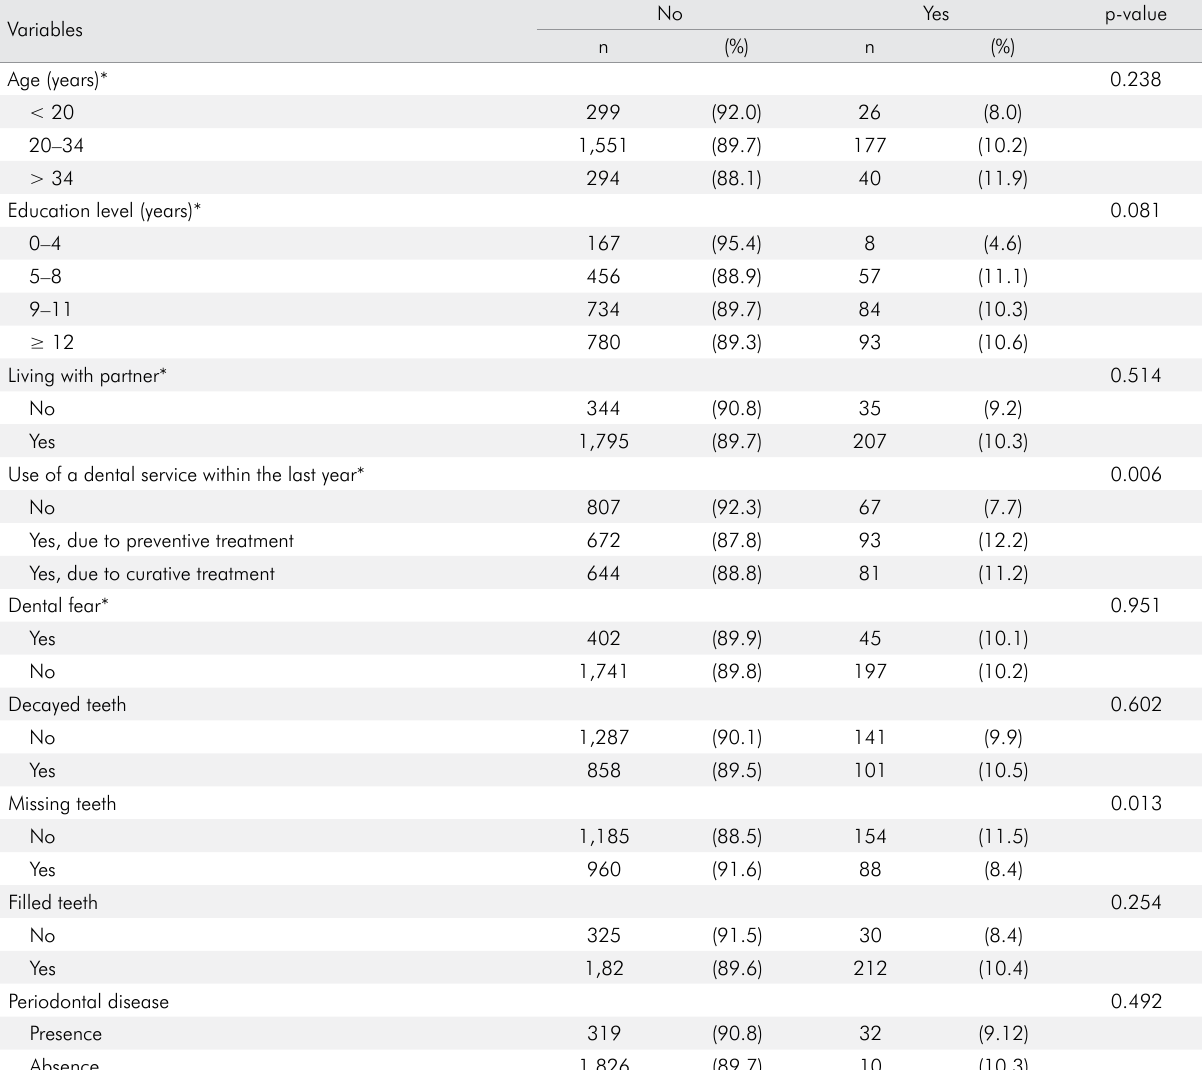
Table 1. Descriptive analyses of the sample sorted by maternal sociodemographic and dental related factors (independent variables) and its distribution according to child use of dental services until 12 months of age in a birth cohort in the city of Pelotas, RS, Brazil, 2020 (n =